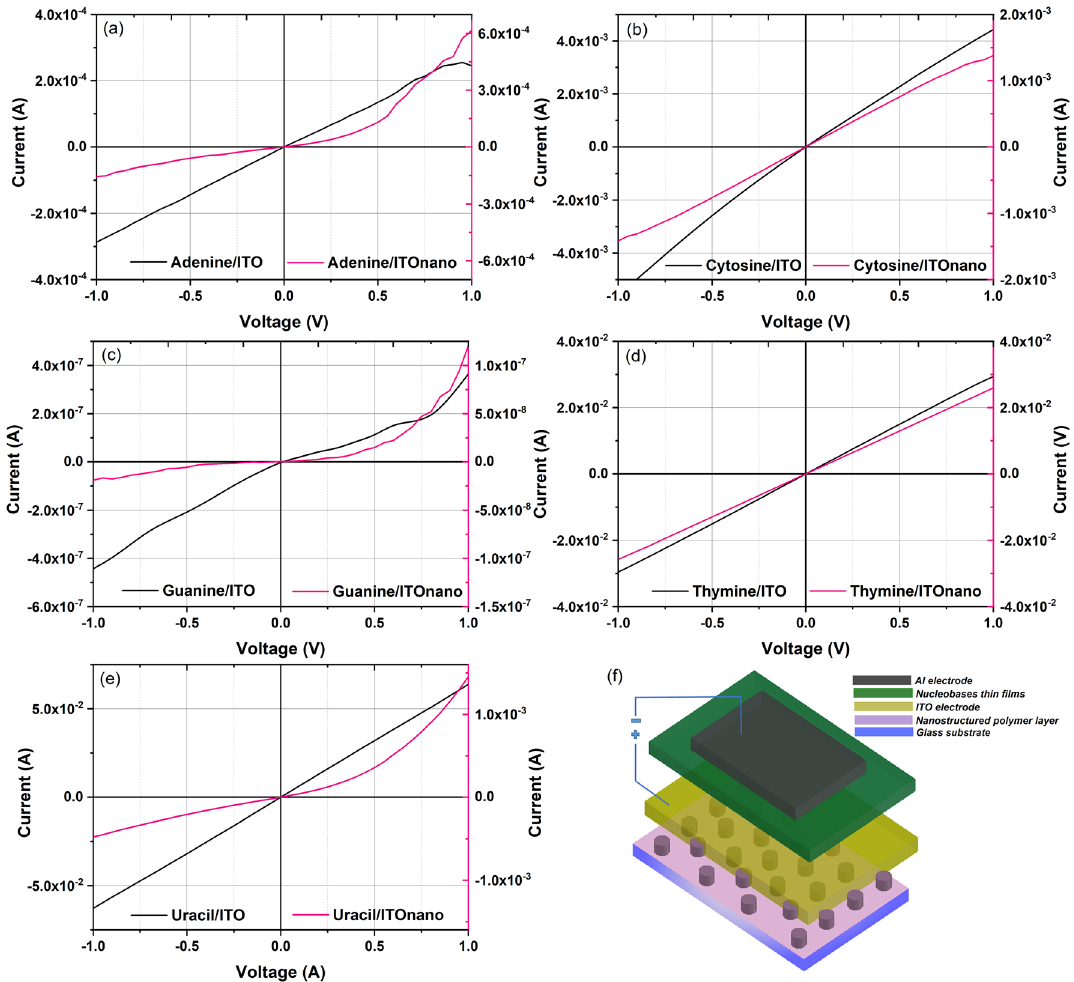
Figure 8. I–V characteristics of the nucleobases thin films based structures: ( a ) adenine, ( b ) cytosine, ( c ) guanine, ( d ) thymine, ( e ) uracil and ( f ) the schematic representation of the investigated heterostructures on nano-patterned TCE electrode (P.46.0.0 AutoCad 2019, https:// www. autod esk. com/ produ cts/ autoc ad/ overv iew? term=1- YEAR& suppo rt=